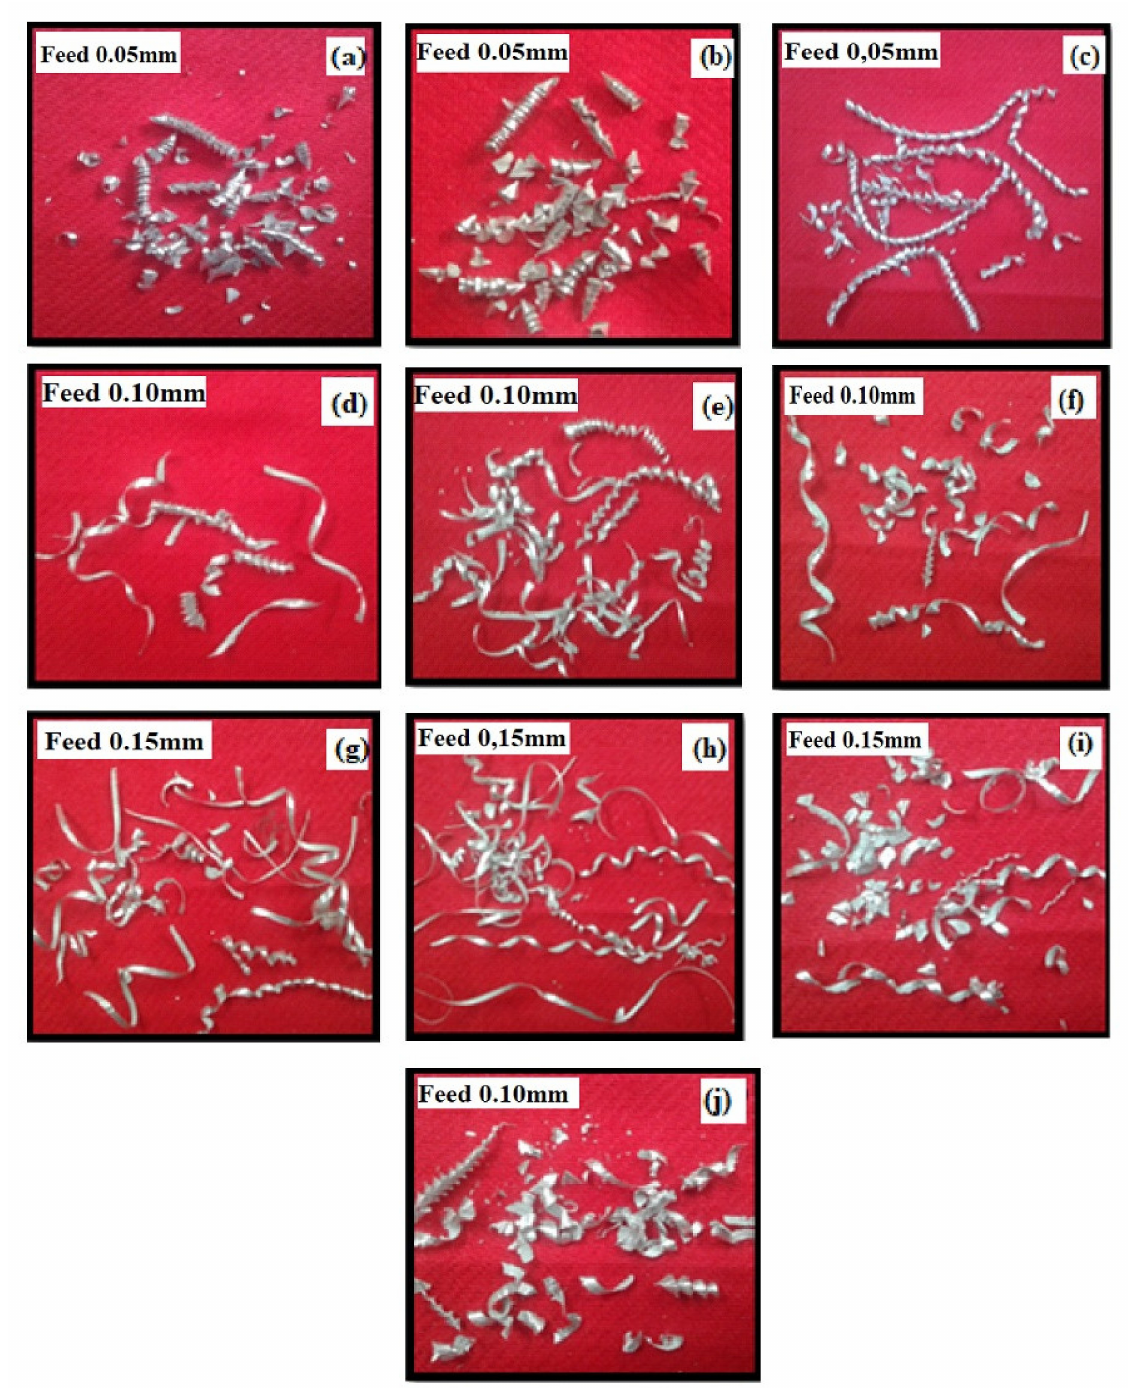
Figure 11. Photographic images of metal chips at ( a ) 0 wt.% TiB 2 at 1000 m/minute, ( b ) 0 wt.% TiB 2 at 1500 m/minute, ( c ) 3 wt.% TiB 2 at 1000 m/minute, ( d ) 3 wt.% TiB 2 at 2000 m/minute, ( e ) 6 wt.% TiB 2 at 1500 m/minute, ( f ) 6.wt.% TiB 2 at 2000 m/minute, ( g ) 9 wt.% TiB 2 at 1000 m/minute, ( h ) 9 wt.% TiB 2 at 1500 m/minute, ( i ) 12 wt.% TiB 2 at 1000 m/minute and ( j ) 12 wt.% TiB 2 at 1500